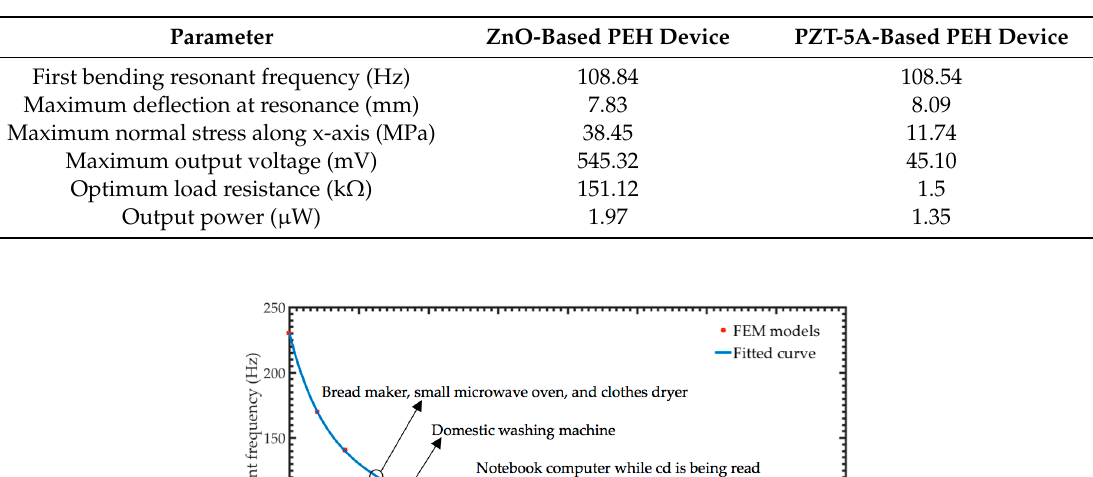
Table 4. Results of the main parameters of the MEMS-based PEH devices obtained using the FEM models.